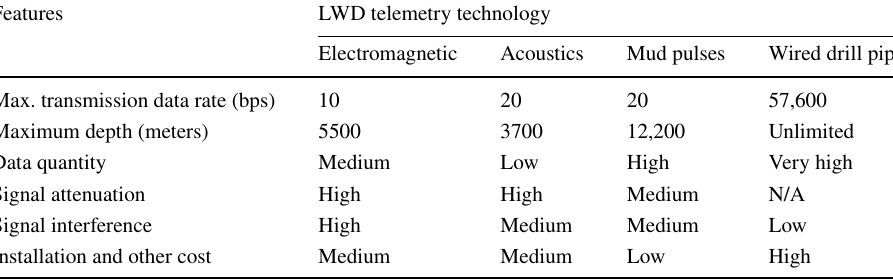
performance among LWD telemetry technologies. (Source: Compiled from literatures)